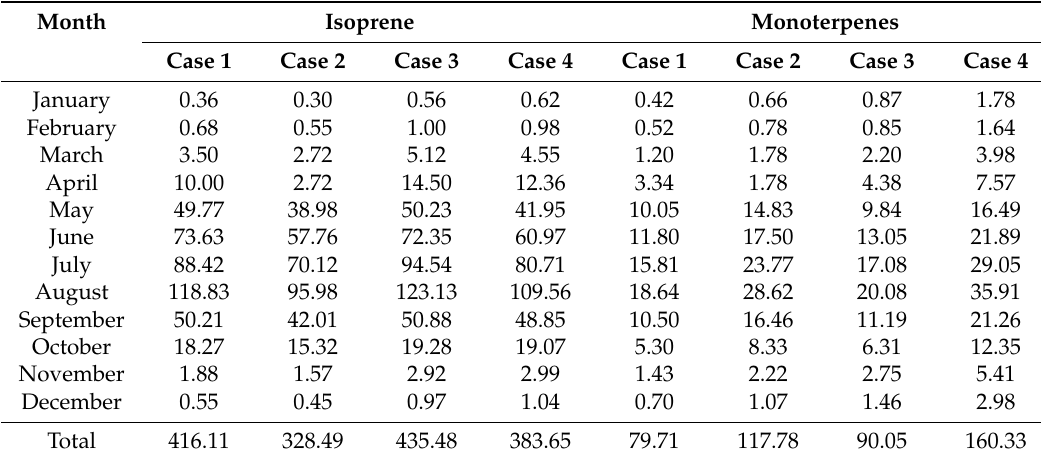
Table 9. Monthly biogenic emissions in South Korea (Gg / period).